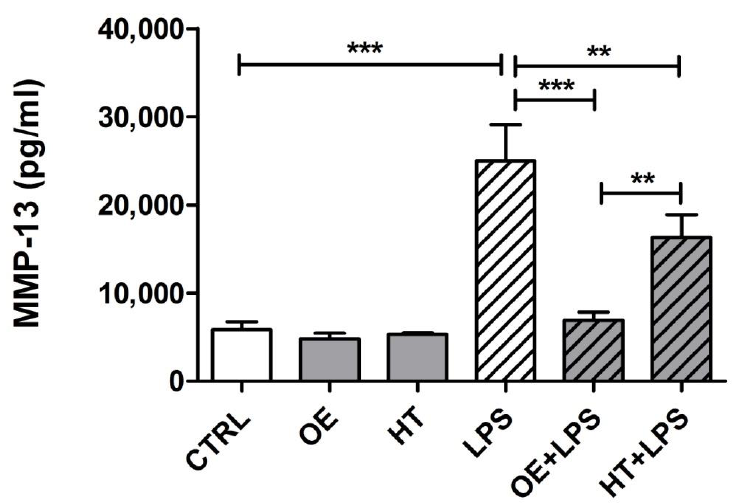
Figure 8. Inhibiting effects of OE and HT pretreatment on LPS-induced MMP-13 release from OA chondrocytes, following 24 h exposure. Cumulative data obtained from three patients (mean ± SEM, n = 3), with triplicate wells seeded for each condition for each patient. Oleuropein was confirmed as exhibiting a complete inhibiting activity on MMP-13 release induced by LPS treatment. Data were compared by ANOVA, followed by Newman–Keuls’, with ** p < 0.01, *** p < 0.001.